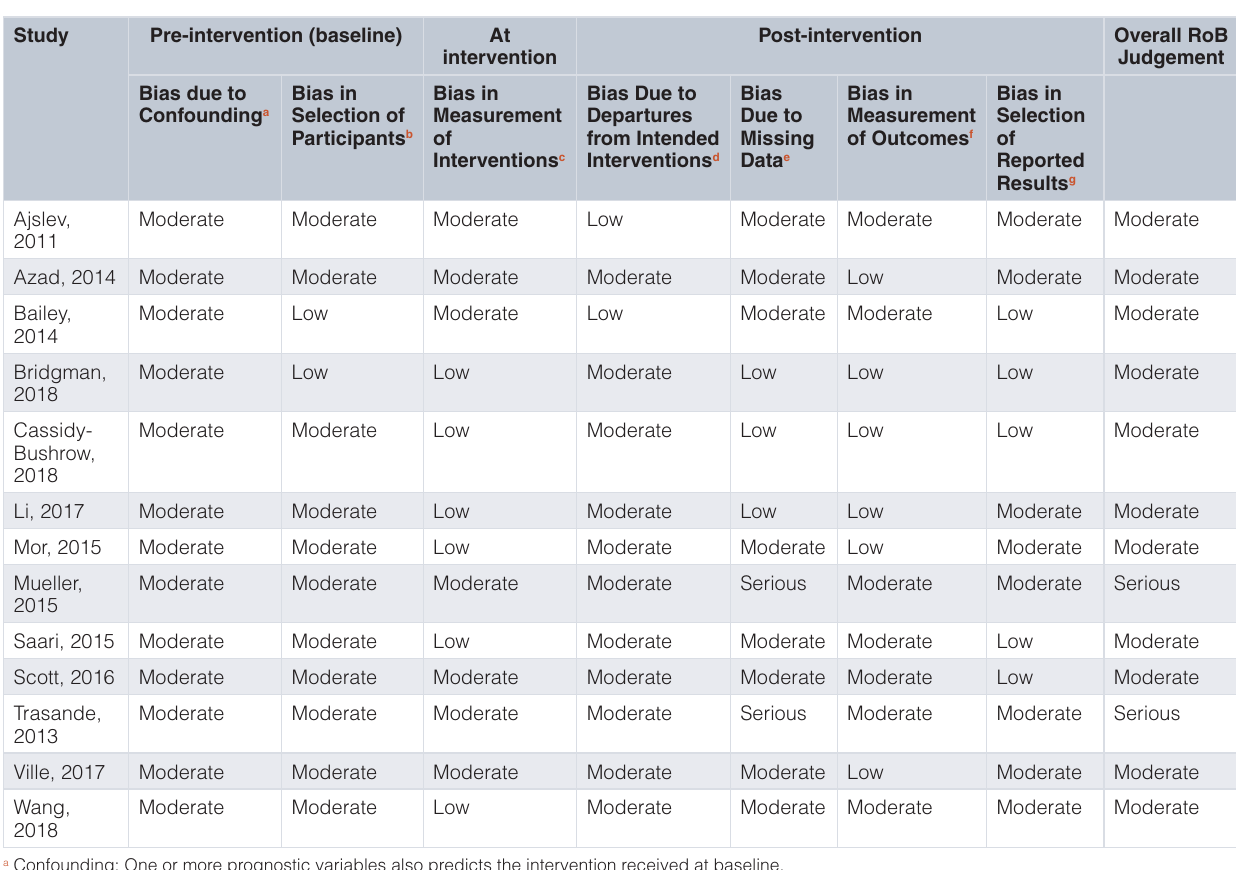
Scott, 2016 Moderate Moderate Moderate Moderate Moderate Moderate Moderate Moderate Moderate Moderate Moderate Low Moderate Moderate Moderate